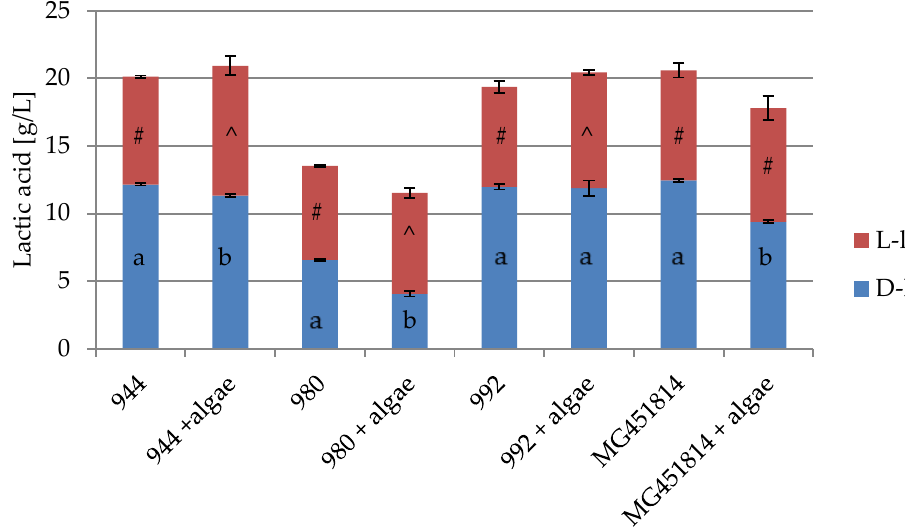
Figure 2. D - and L -lactic acid produced by Lactobacillus brevis ŁOCK 0944, 0980, 0992, and MG451814 cultured with and without algae Chlorella vulgaris. a, b—the statistically significant differences between samples of the same strains within one time interval for D-lactic acid; p < 0.05; #, ^—the statistically significant differences between samples of the same strains within one time interval for L -lactic acid; p < 0.05; n = 3.